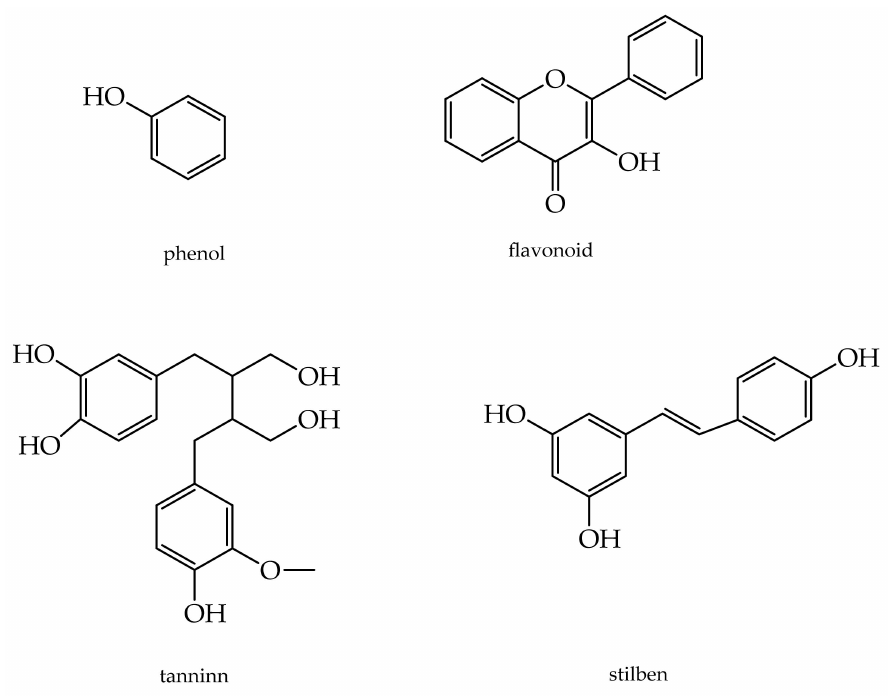
Figure 3. Structures of the most widespread